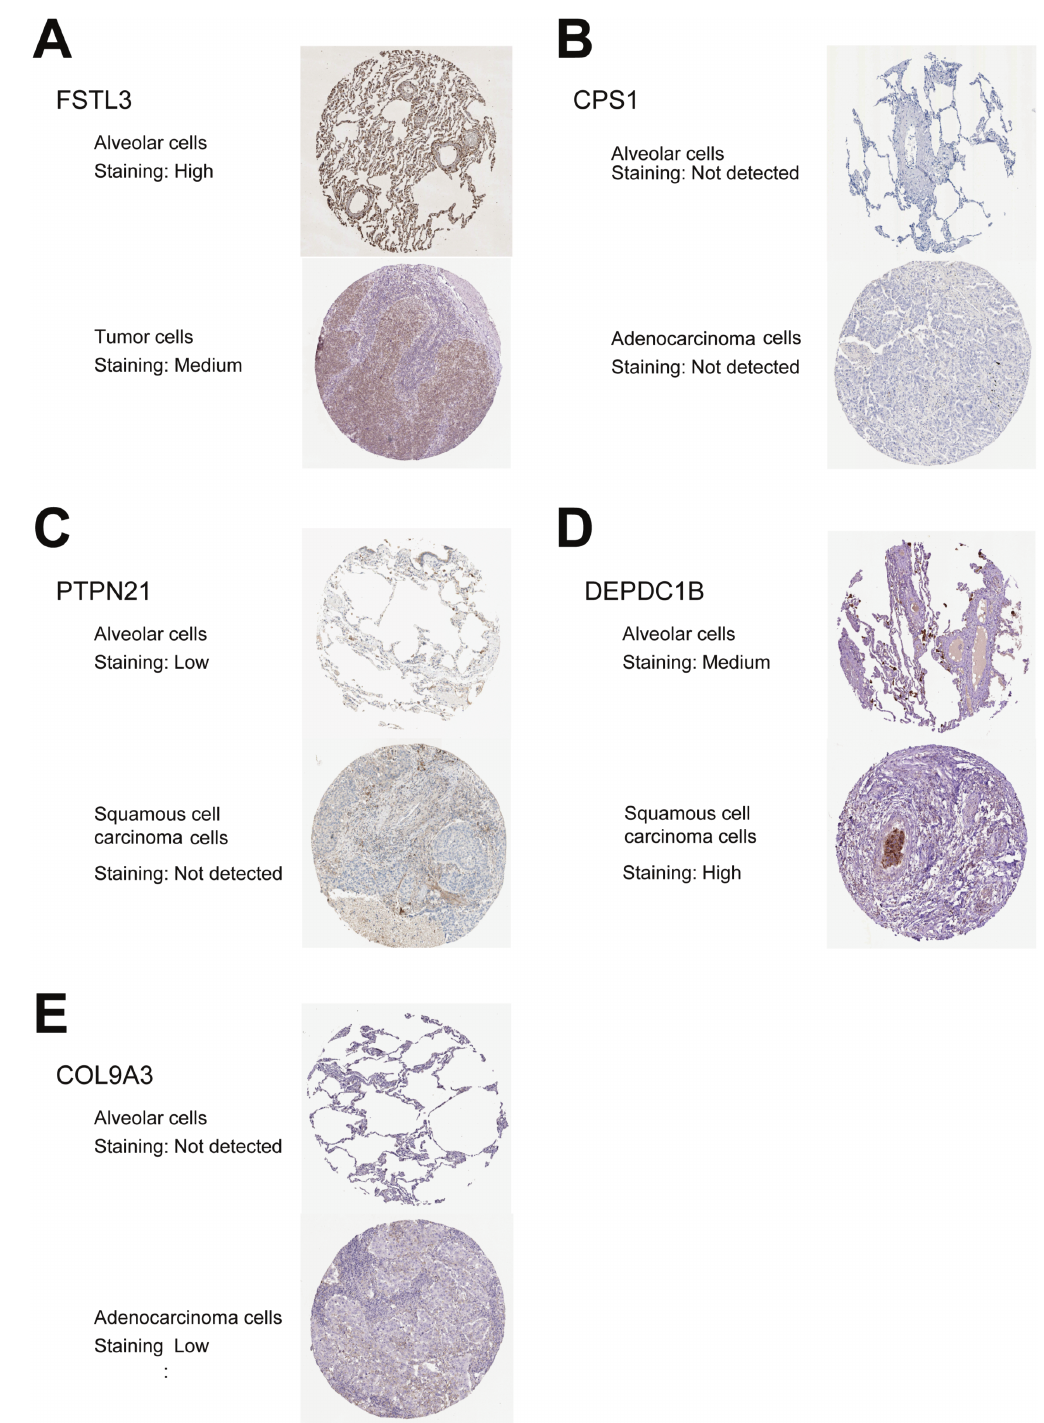
Fig 9. Validation of the risk mRNAs in ceRNA network by using the human protein atlas database. (A-E) Validation of FSTL3, CPS1, PTPN21, DEPDC1B, and COL9A3 by The Human Protein Atlas database (IHC) at the protein level. ceRNA, Competing endogenous RNA; IHC, immunohistochemistry.